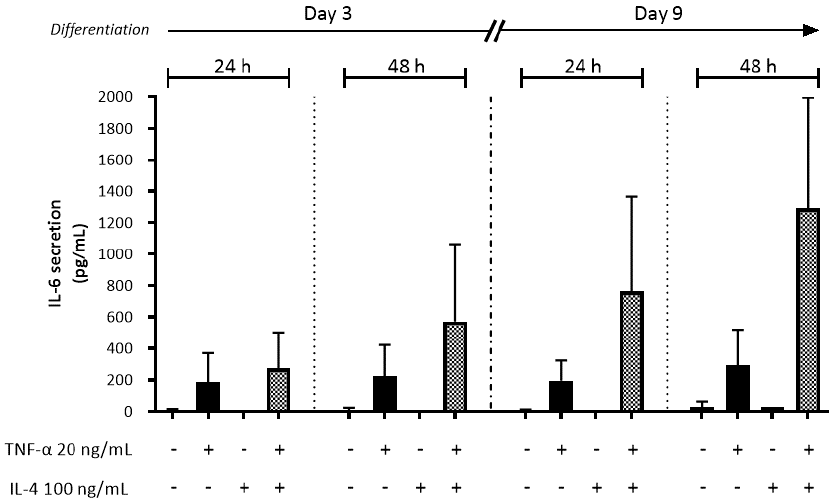
Figure A3. Preliminary time course experiment aimed at assessing IL-6 release from HaCaT cells stimulated with TNF-α (10 ng/mL), IFN-γ (5 ng/mL), or a combination of both; ** p < 0.01, *** p < 0.001 vs. stimulus.